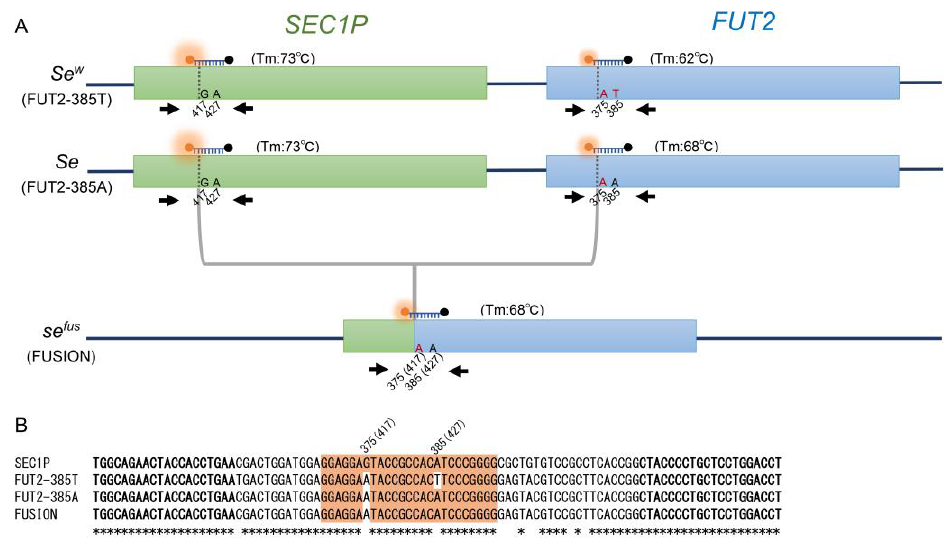
Figure 1. Genomic structure of FUT2 , SEC1P , and se fus , and primer and probe positions used ( A ). The protein coding region of FUT2 (FUT2-385A and FUT2-385T) is indicated by a blue box, that of SECIP is indicated by a green box, and that of se fus is indicated by green and blue boxes. The relative positions of the primers and probe anneal are indicated by black arrows, and the probe is indicated, in black combined with a fluorophore labeled at the 5′ end and a quencher labeled at the 3′ end. Nucleotides that differ from the sequence of the probe are indicated by red letters. Alignment of DNA sequences of amplified regions in FMCA; DNA sequences of FUT2 (FUT2-385A: allele of A at rs1047781; FUT2-385T: allele of T at rs1047781; FUSION: se fus allele) and corresponding regions of SEC1P , are indicated ( B ). Forward primer and reverse primer sequences are shown in bold. The probe sequence is indicated by orange boxes and nucleotides that differ from the sequence of probe are